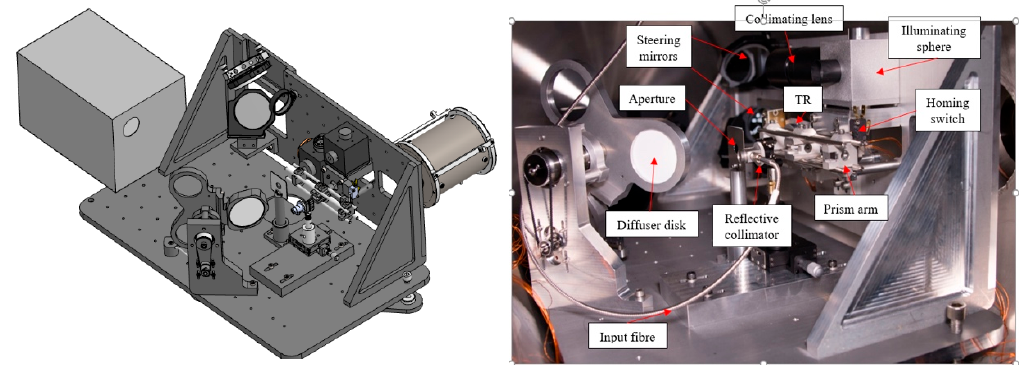
Figure 7. Computer-aided design drawing of laboratory breadboard of the TRUTHS OBCStogether with a photograph of its engineering realisation before testing in a vacuum tank.